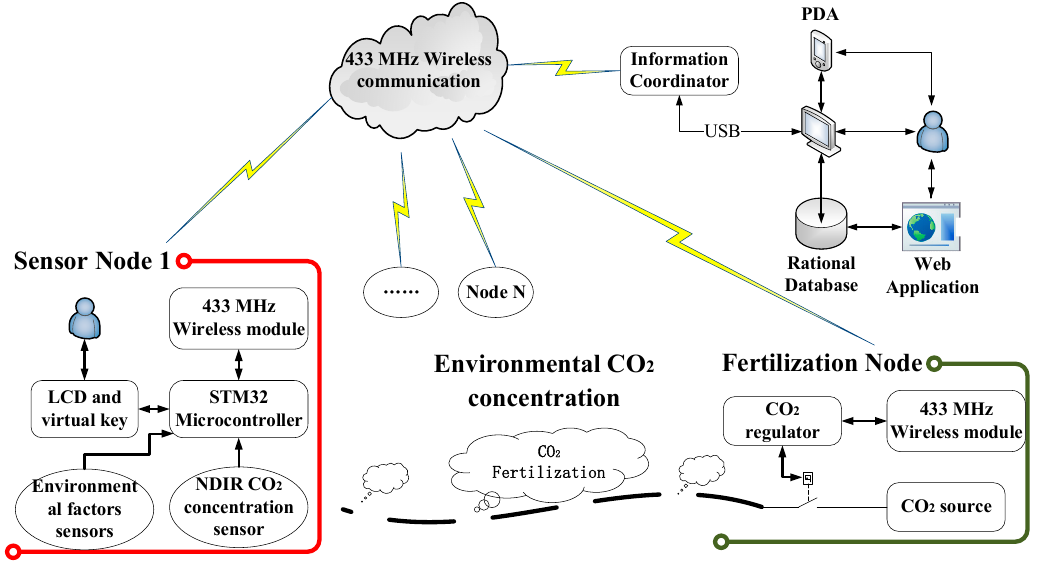
Figure 1. Structure of the CO 2 monitoring and control system based on wireless network in a greenhouse environment.